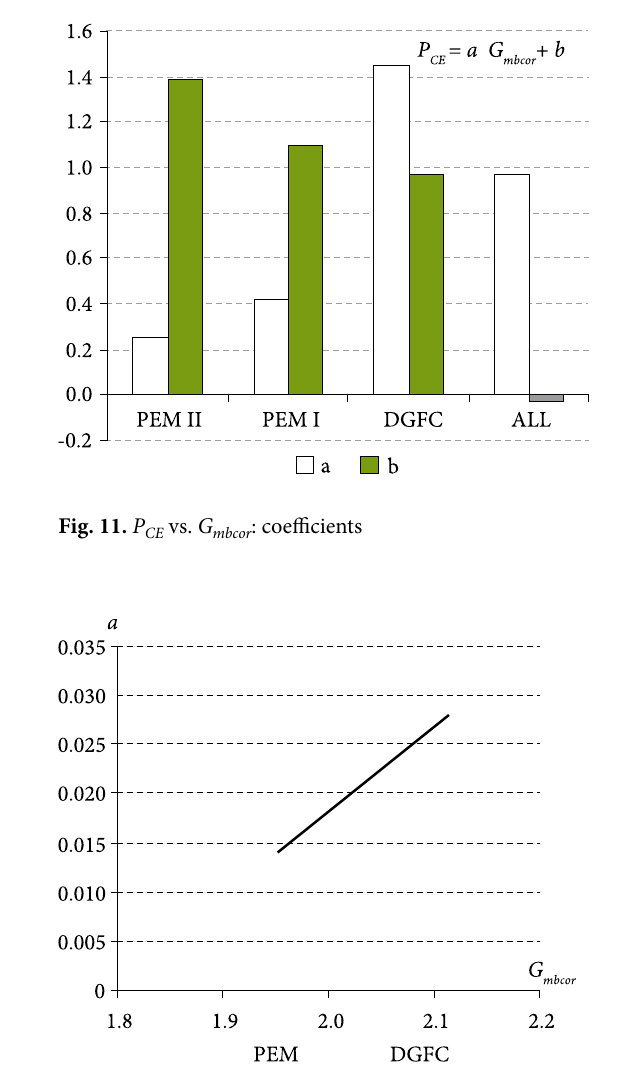
Fig. 12. Constant b of the correlation P CE = aW + b